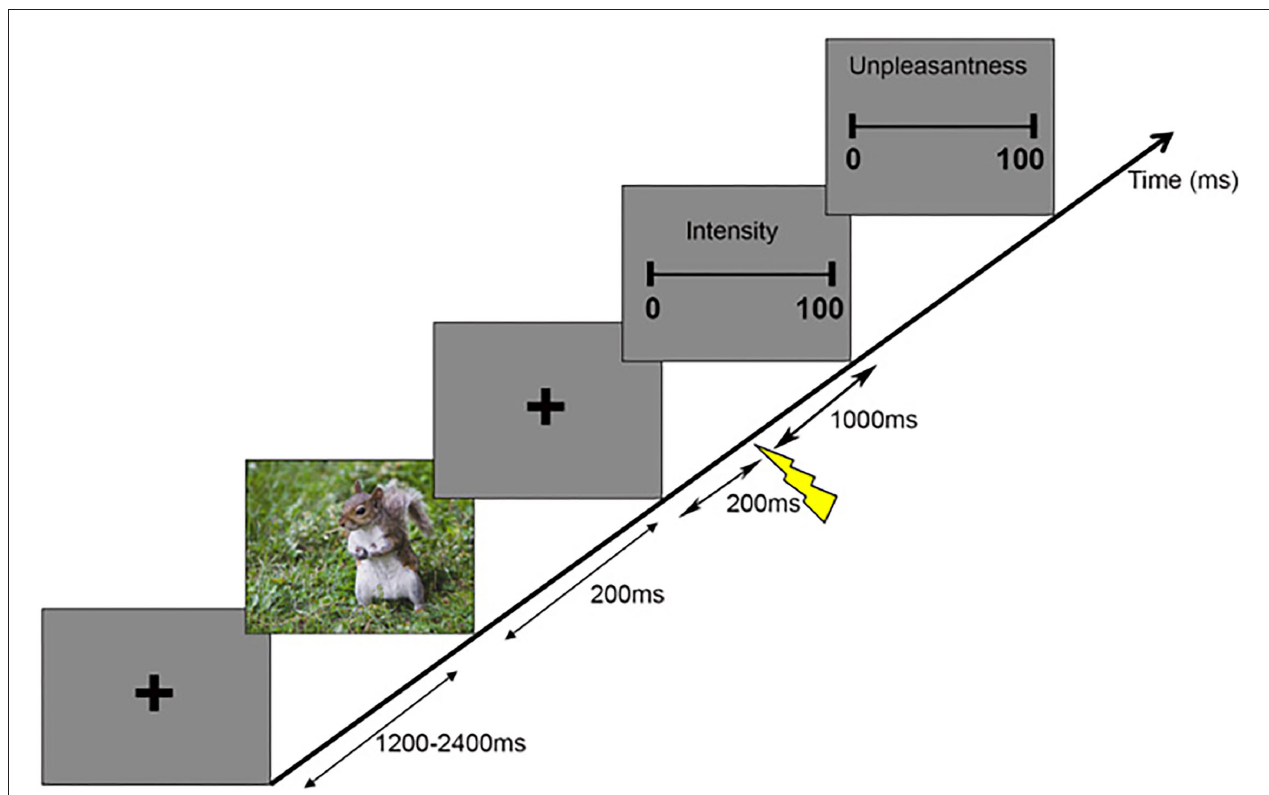
FIGURE 1 | Schematic representation of the experimental paradigm. Each trial began with a fixation cross with a variable duration between 1,200 and 2,400ms, followed by a picture lasting 200ms. Then, another fixation cross was presented for 1,200ms, during which painful stimuli were applied at a frequency of 3–7Hz starting 200ms after the prime picture. Then, two consecutive scales appeared, where participants indicated the intensity and unpleasantness of the perceived painful